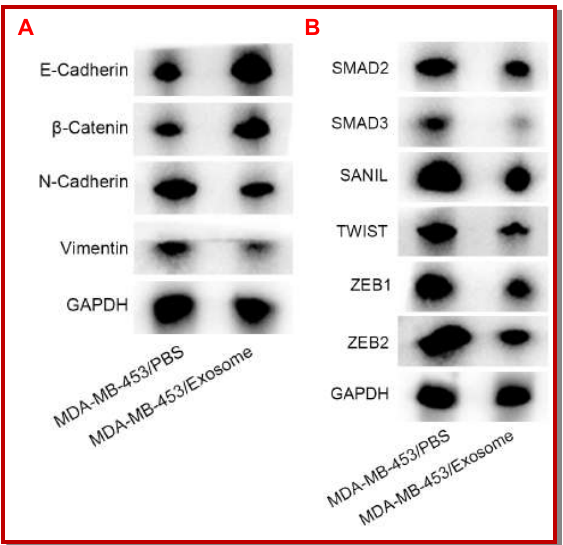
Figure 5: Exosomes derived from zoledronic acid-treated MDA-MB-453 cells suppressed the EMT progression and TGF- β signal pathway. The expression level of E-cadherin, β -catenin, N-cadherin, and vimentin was determined by Western blotting (A). The expression level of SMAD2, SMAD3, SNAIL, TWIST, ZEB1, and ZEB2 was determined by Western blotting (B)